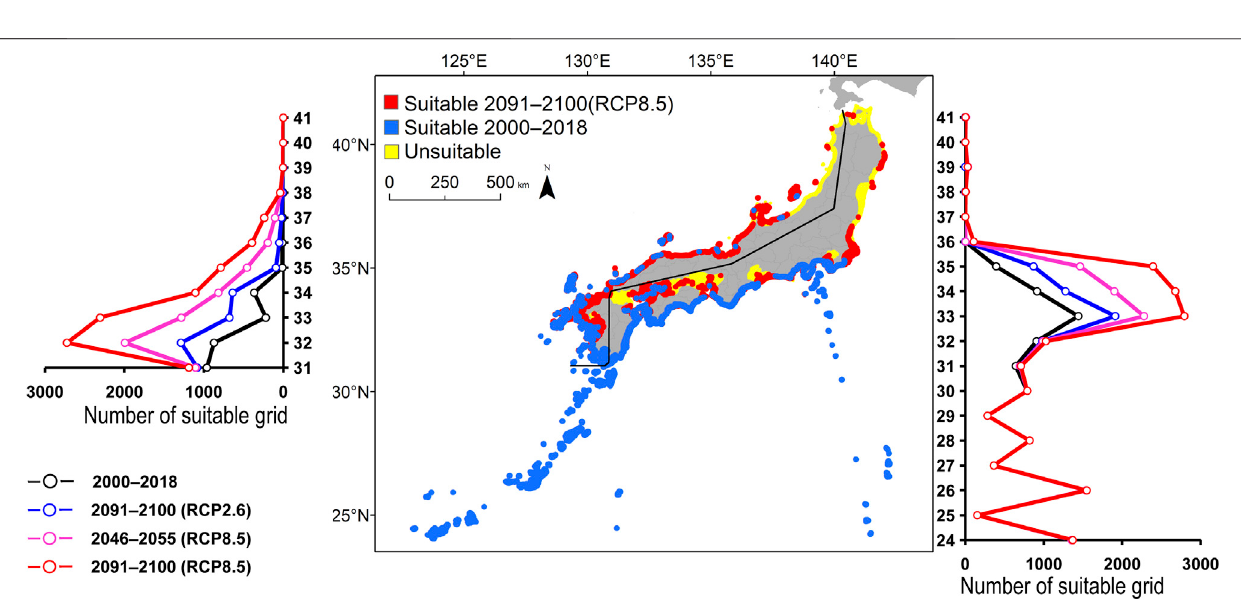
Frontiers in Built Environment |